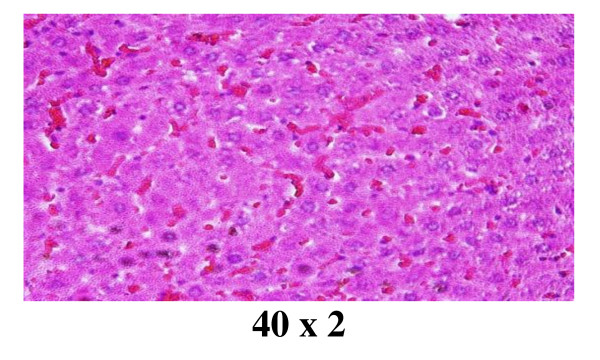
GNPs-treated rat received 50 μl of 10 nm particles for 7 days